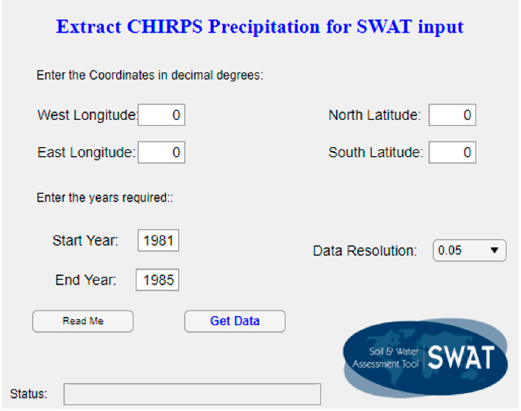
Figure 2. Screenshot of the Chirps4SWAT tool to extract the Climate Hazards Group InfraRed Rainfall with Station data (CHIRPS) rainfall data.